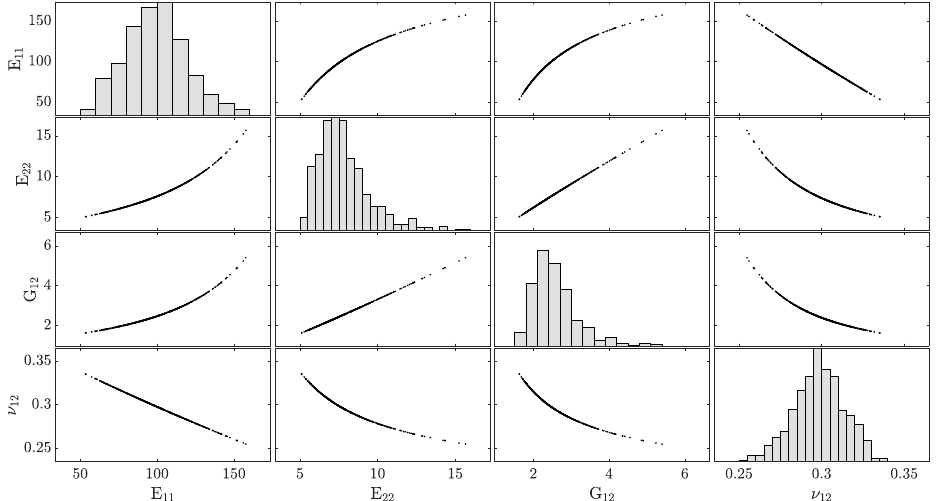
Figure 7. The qualitative relationships between pairs of parameters. The diagonal plots represent the distribution of parameters. The off-diagonal plots show the linear and nonlinear relationships of the elastic parameters.